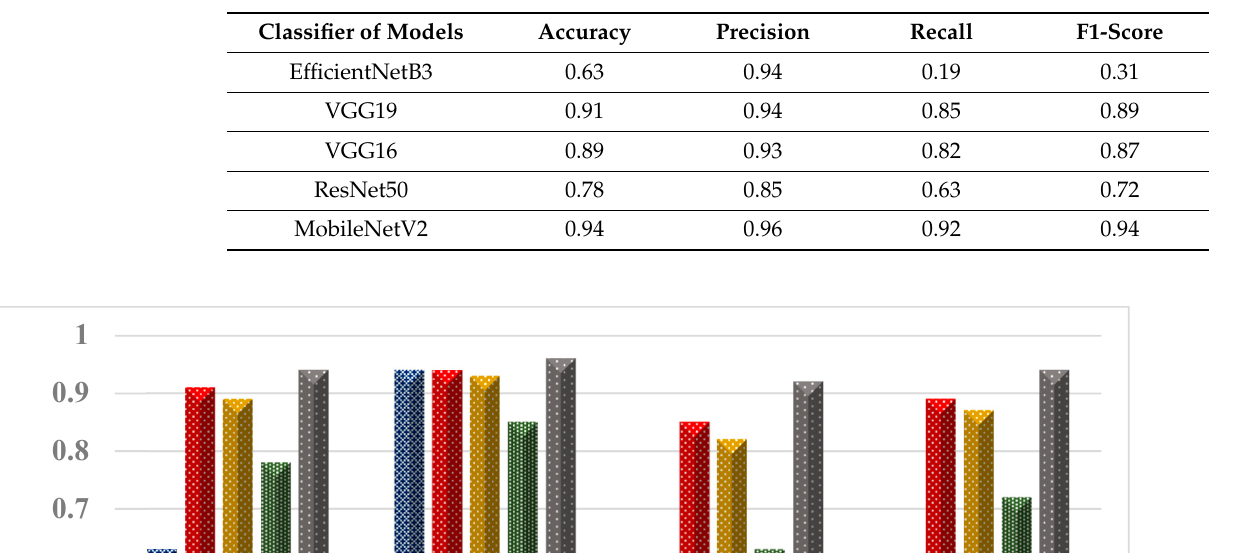
Table 7. Performance of the model validation with the MSLD dataset [5].